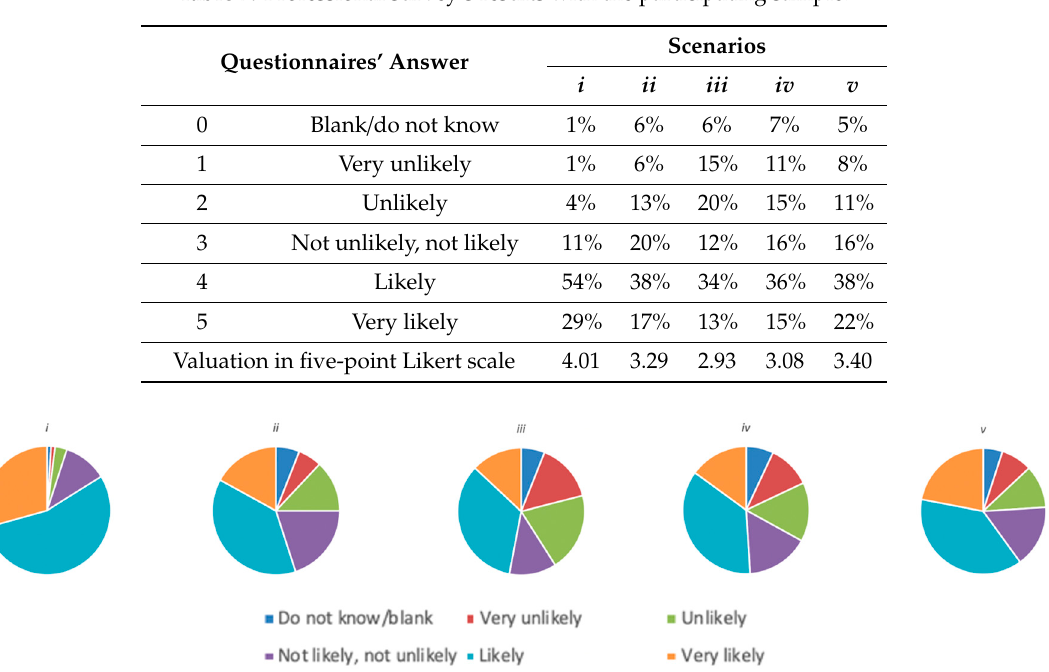
Figure 5. Five scenario Likert assortment survey analysis from the simple additive weighting (SAW) and sensitivity analysis.